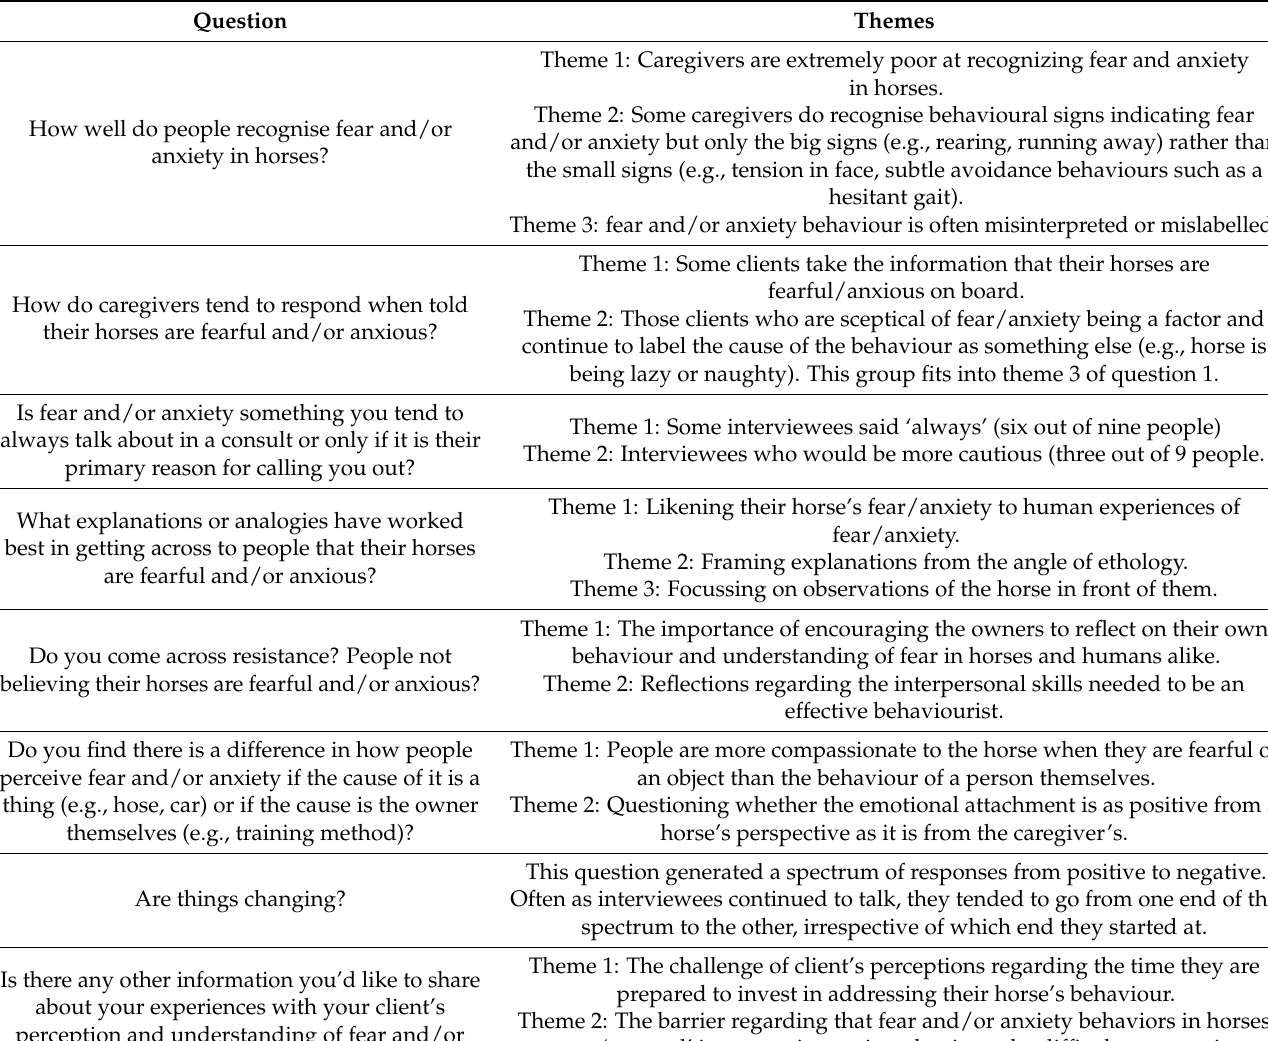
Table 1. The eight questions and the resulting summary and